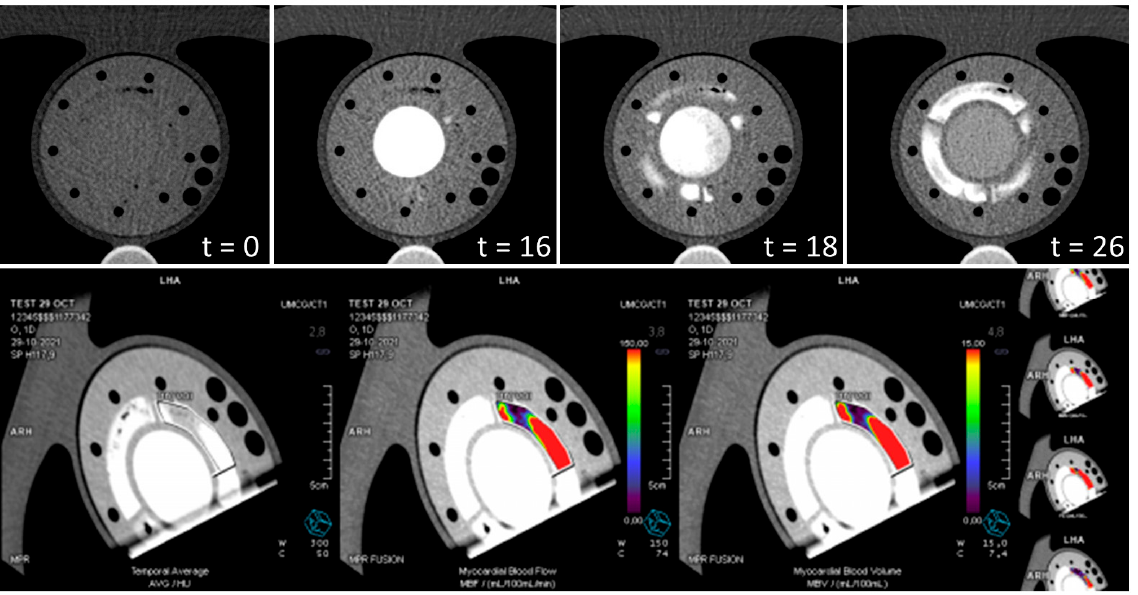
Figure 5. Example of CT myocardial perfusion image analysis. ( Top ) visualization of a time-lapse across a short axis plane of the phantom showing contrast arrival and distribution in the mimicked left ventricular cavity (center) and three surrounding myocardial regions (t = 0 s, 16 s, 18 s, 26 s). The rightmost tissue region simulates a perfusion deficit (flow of 40 mL/min instead of 80 mL/min). ( Bottom ) a typical software display of CT myocardial perfusion image analysis in consecutive image slices. The level of estimated myocardial blood flow within the manually delineated volume of interest is visualized by the added color and ranges from 0 (purple) to 150 mL/100 mL/min